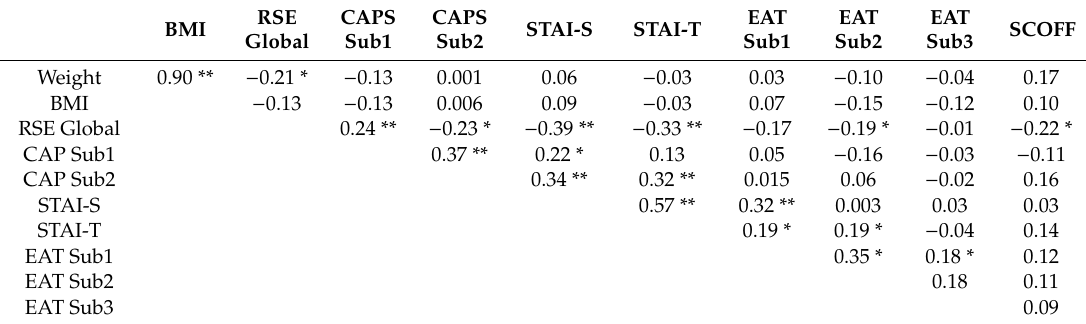
Table 3. Spearman’s correlations between the main variables.